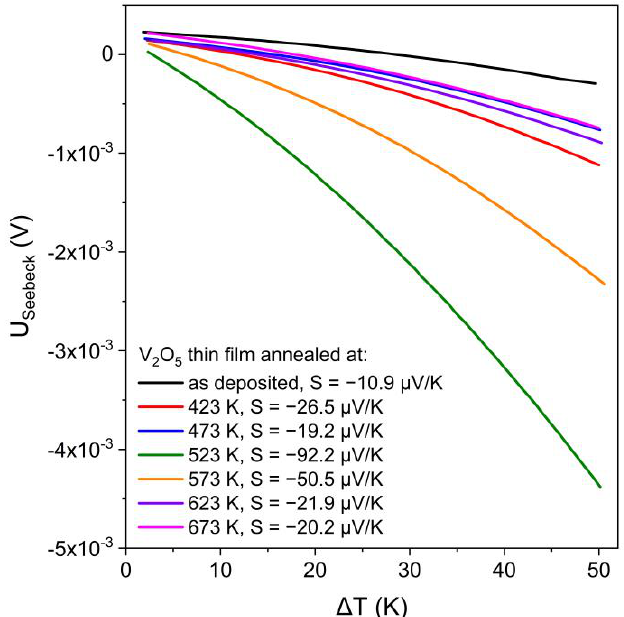
Figure 9. Thermoelectrical voltage characteristics of as-deposited and annealed vanadium oxide thin films with calculated Seebeck coefficients.